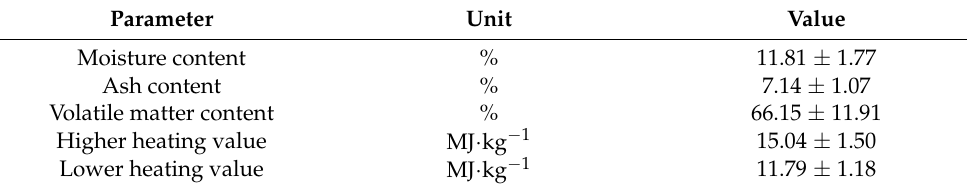
Table 7. Results of the analysis of beet